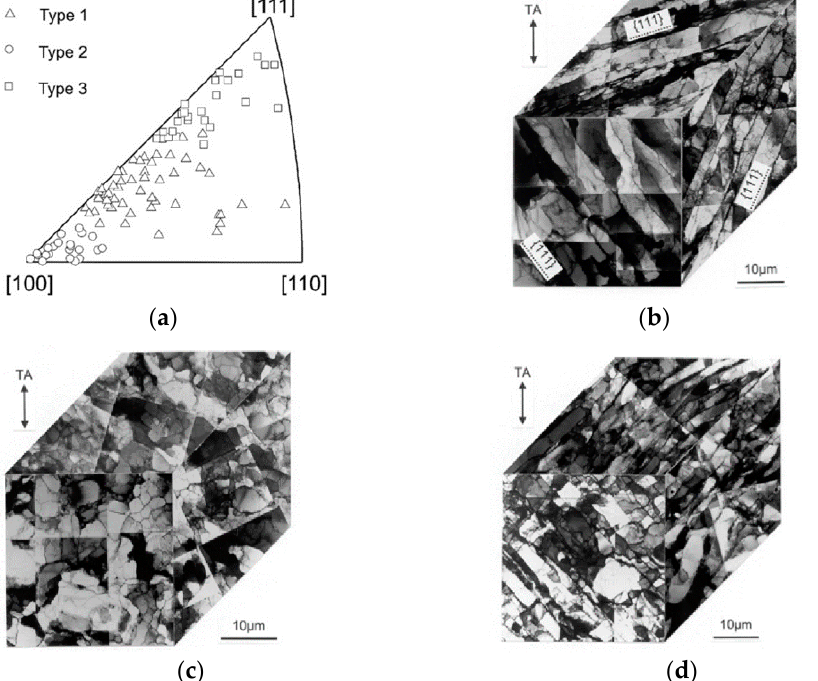
Figure 5. The dislocation structures of a 99.99% aluminum alloy that was deformed by tension: ( a ) the TA orientations of 100 of the grains examined; ( b – d ) the TEM diagrams of grains with type I, II and III structures, respectively [62].